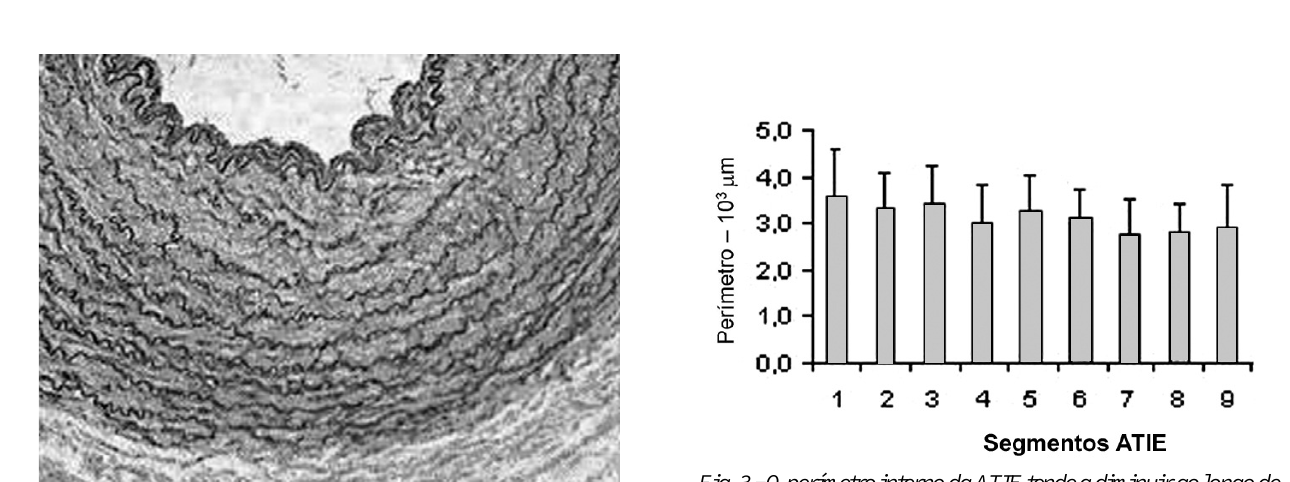
Fig. 3 - O perímetro interno da ATIE tende a diminuir ao longo de sua extensão